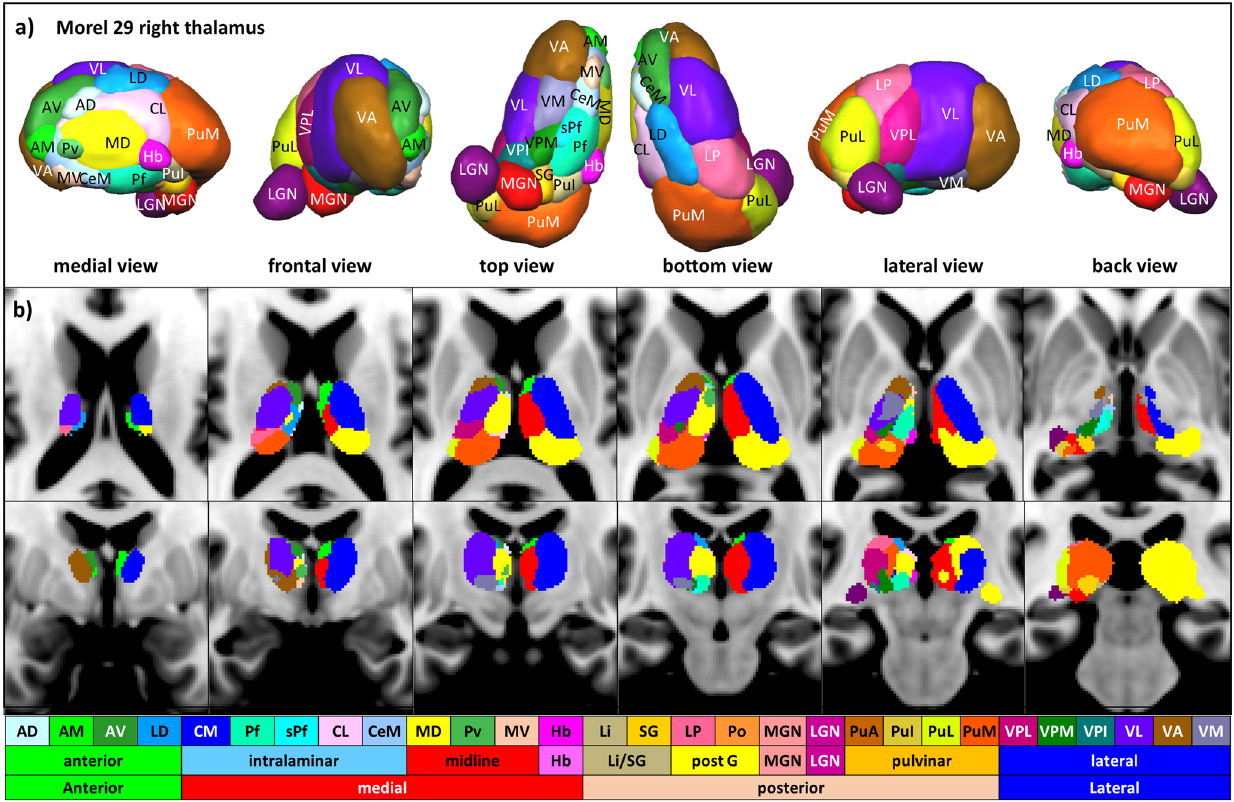
Fig. 2 Anatomy of the thalamus. a 3D Rendered views of 29 thalamic nuclei of Morel ’ s histological atlas with abbreviations. b Depiction of thalamic nuclei and nuclei groups of the Morel atlas six axial and coronal views (Krauth et al. 92 ). The nuclei depiction is color-coded with respect to each nucleus. The detailed color assignments in hex color code: AD (CBFFFF), AM (41FB30), AV (359430), LD (1AA0FC), MD (FFFC38), CM (002CFB), Pf (3FFDB6), sPf (3CFEFE), CL (FDCAFE), CeM (98C9FD), Pv (52B755), MV (FDC8AC), Hb (F933FC), Li (C0B47F), SG (FECE30), LP (FA6897), Po (FC963F), MGN (FA141B), LGN (711172), PuA (C56419), PuI (DCC642), PuL (DCFC36), PuM (FA571F), VPL (C2187B), VPM (1C7F13), VPI (177877), VL (612DFB), VA (965B15), VM